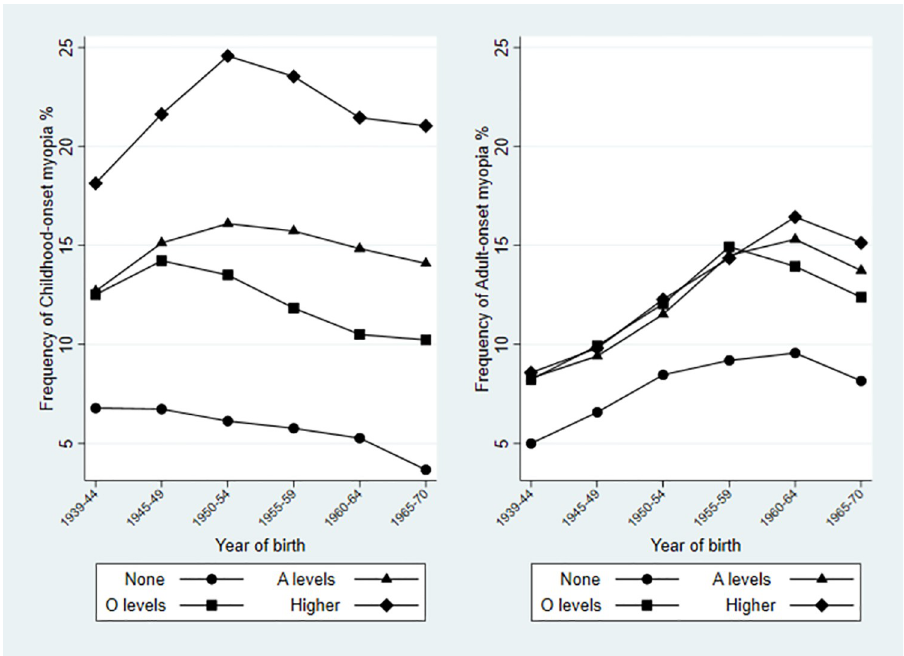
Fig 4. Frequency of (a) childhood-onset and (b) adult-onset myopia by highest educational attainment � , by year of birth as 5-year bands. � No qualifications, ‘O’ levels (examinations at statutory school-leaving age in the UK), ‘A’ levels (examinations at age 18 years in the UK) or higher level of